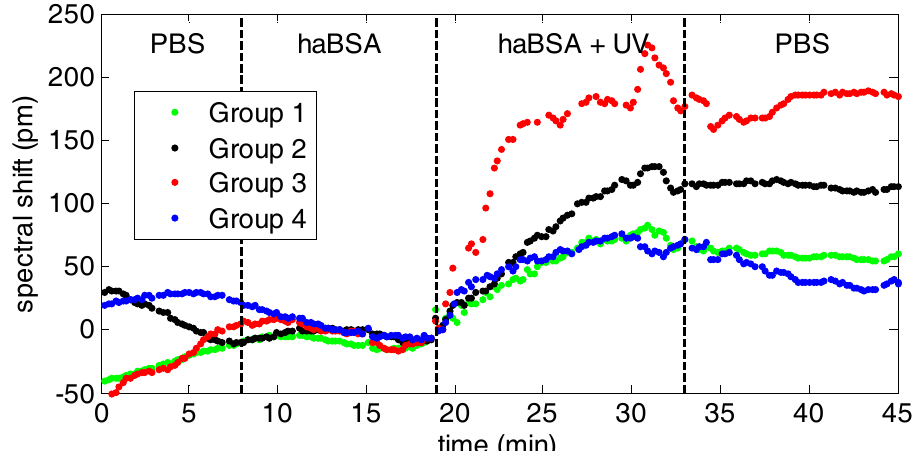
Figure 11. Temporal evolution of the PBG spectral shift during the real time monitoring of the UV light-assisted immobilization of the thiol-terminated haBSA over the vinyl-terminated SOI surface. haBSA are injected at minute 8 and the UV light source is switched on at minute 19.